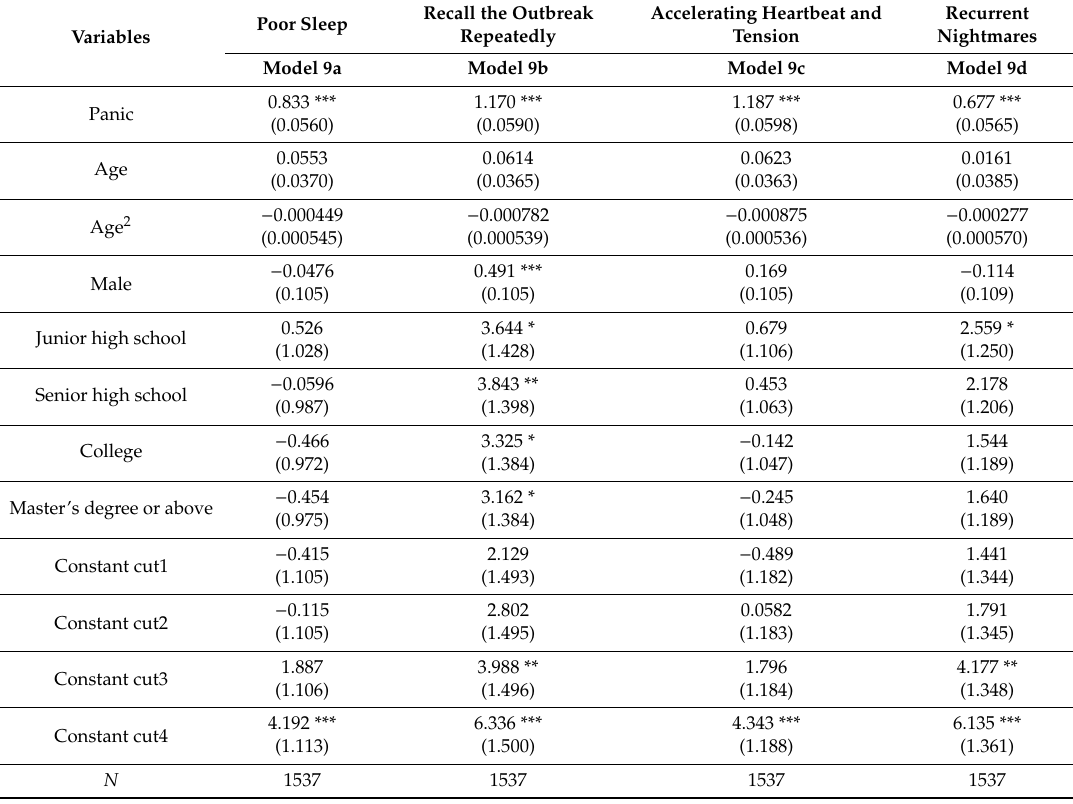
Table 5. Ordinal logistic models of panic